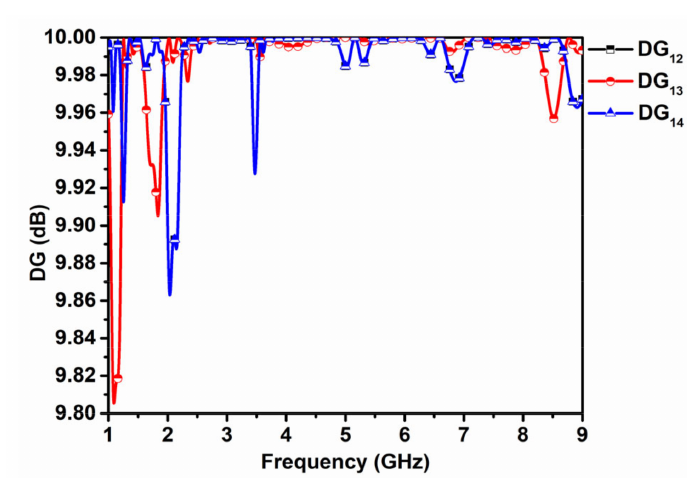
Figure 9. DG of the quad-port